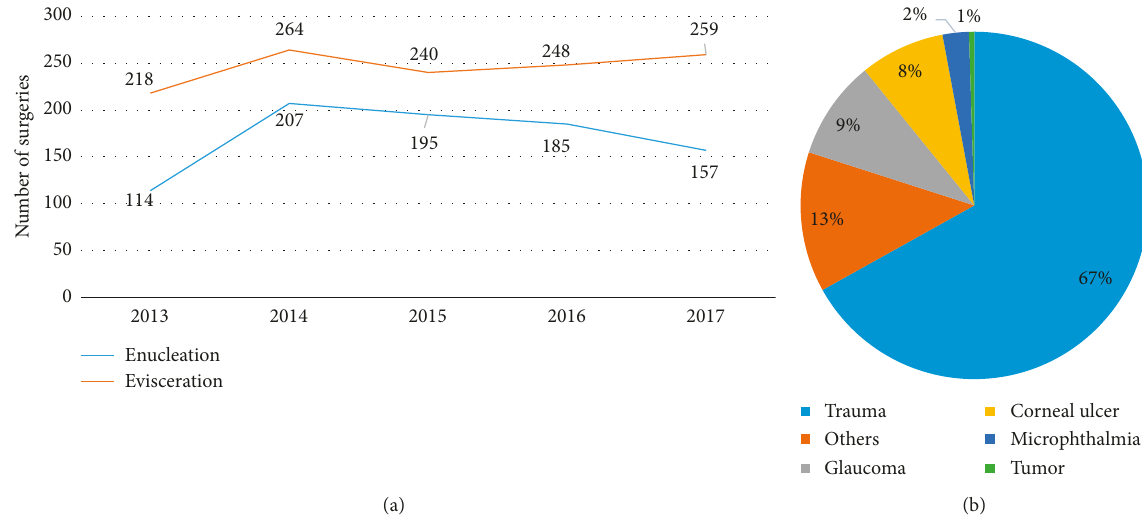
Figure 1: Number of eviscerations performed per year and major causes of evisceration. (a) Number of eviscerations and enucleations performed was 246 ± 18 and 286 ± 37 cases per year, respectively, between 2013 and 2017. (b) Trauma was the major cause (67%) for evisceration; glaucoma and corneal ulcer were responsible for 9% and 8% of the evisceration cases, respectively.